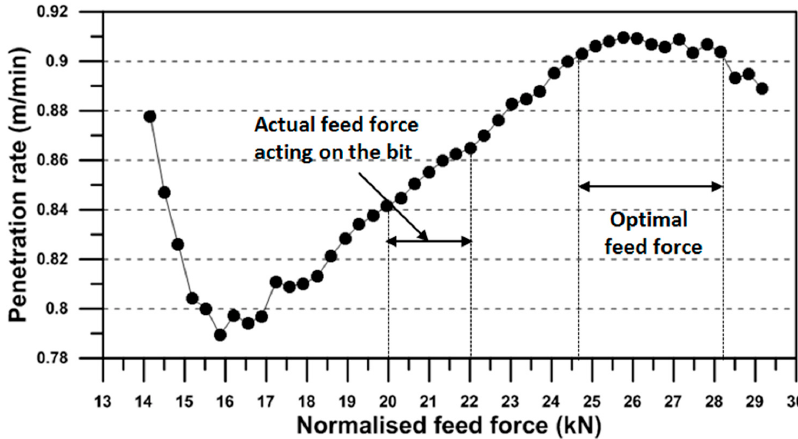
Figure 11. Penetration rate versus normalised feed force.